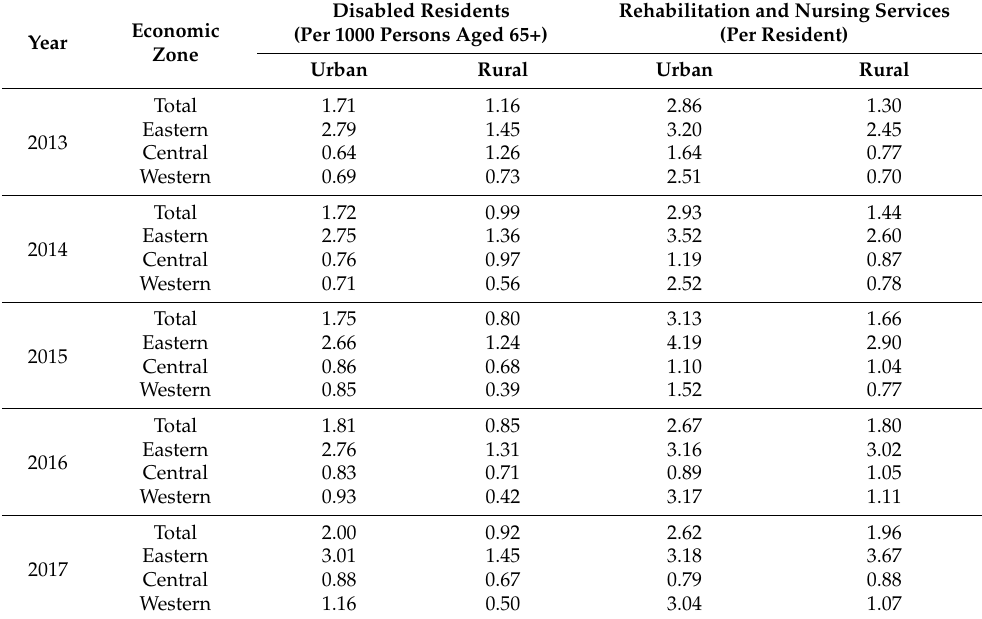
Table 5. LTC resources and service utilization (2013–2017). Disabled Residents Economic (Per 1000 Persons Aged 65+) Year Zone Urban